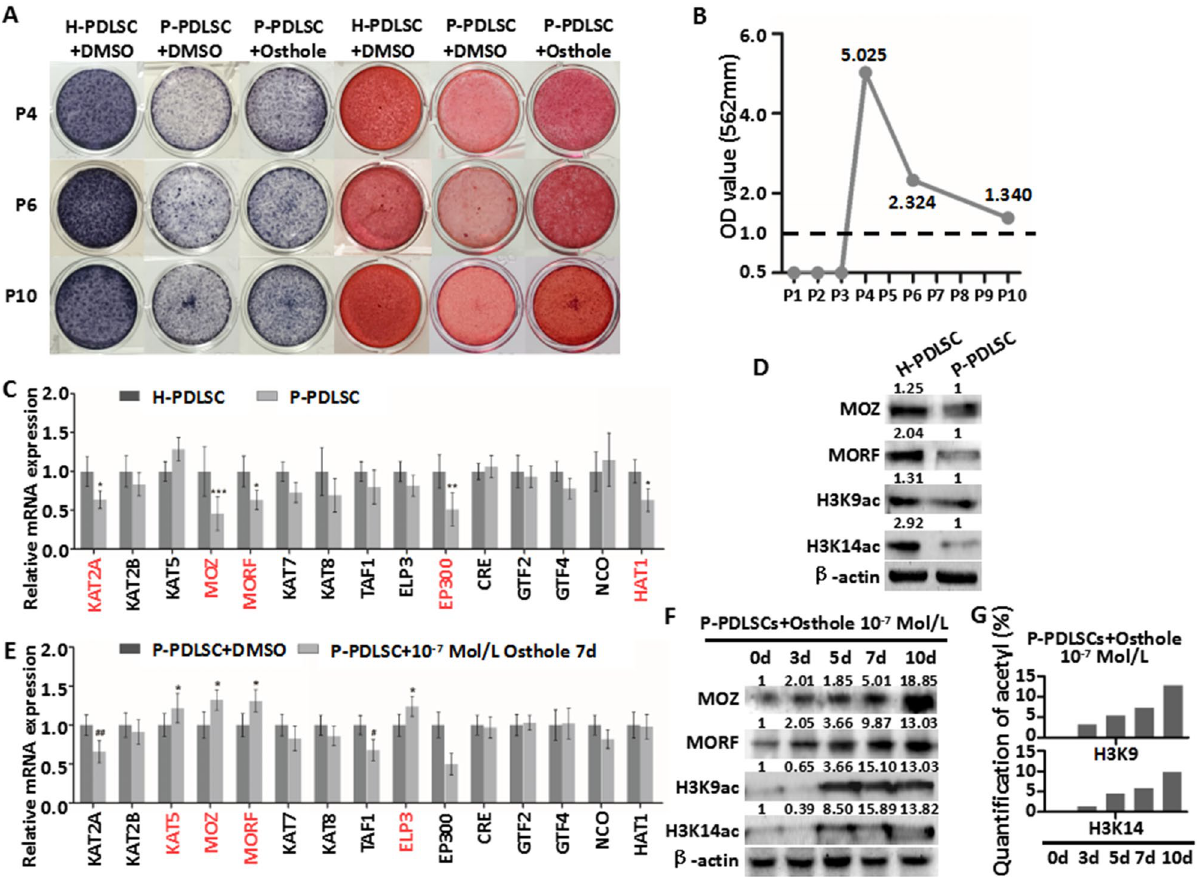
Figure 2. Osthole reverses defective osteogenesis of P-PDLSCs through histone acetylation. ( A ) ALP staining and ARS staining of H-PDLSCs, P-PDLSCs and P-PDLSCs with 10 −7 Mol/L Ostholes in P4 (with stimulation), P6 (without stimulation) and P10 (without stimulation). ( B ) Quantification of ARS staining for light absorbance at 562 nm. ( C ) qRT-PCR showed gene expression of fifteen histone acetylases in H-PDLSCs and P-PDLSCs. ( D ) Protein expression of MOZ, MORF, H3K9ac and H3K14ac in H-PDLSCs and P-PDLSCs as assayed by western blot. ( E ) qRT-PCR showed gene expression of fifteen histone acetylases in P-PDLSCs and P-PDLSCs with 10 −7 Mol/L Osthole measured by qRT-PCR. ( F ) Protein expression of MOZ, MORF, H3K9ac and H3K14ac in P-PDLSCs with 10 −7 Mol/L Osthole treatment on day 0, 3, 5, 7, 10 as assayed by western blot. ( G ) Level of acetylation of H3K9 and H3K14 in P-PDLSCs with 10 −7 Mol/L Osthole treatment on day 0, 3, 5, 7, 10 as assayed by EpiQuik Global Acetyl Histone Quantification Kit. * P < 0.05, ** P < 0.01, *** P < 0.001, no mark: P ≧ 0.05, n =